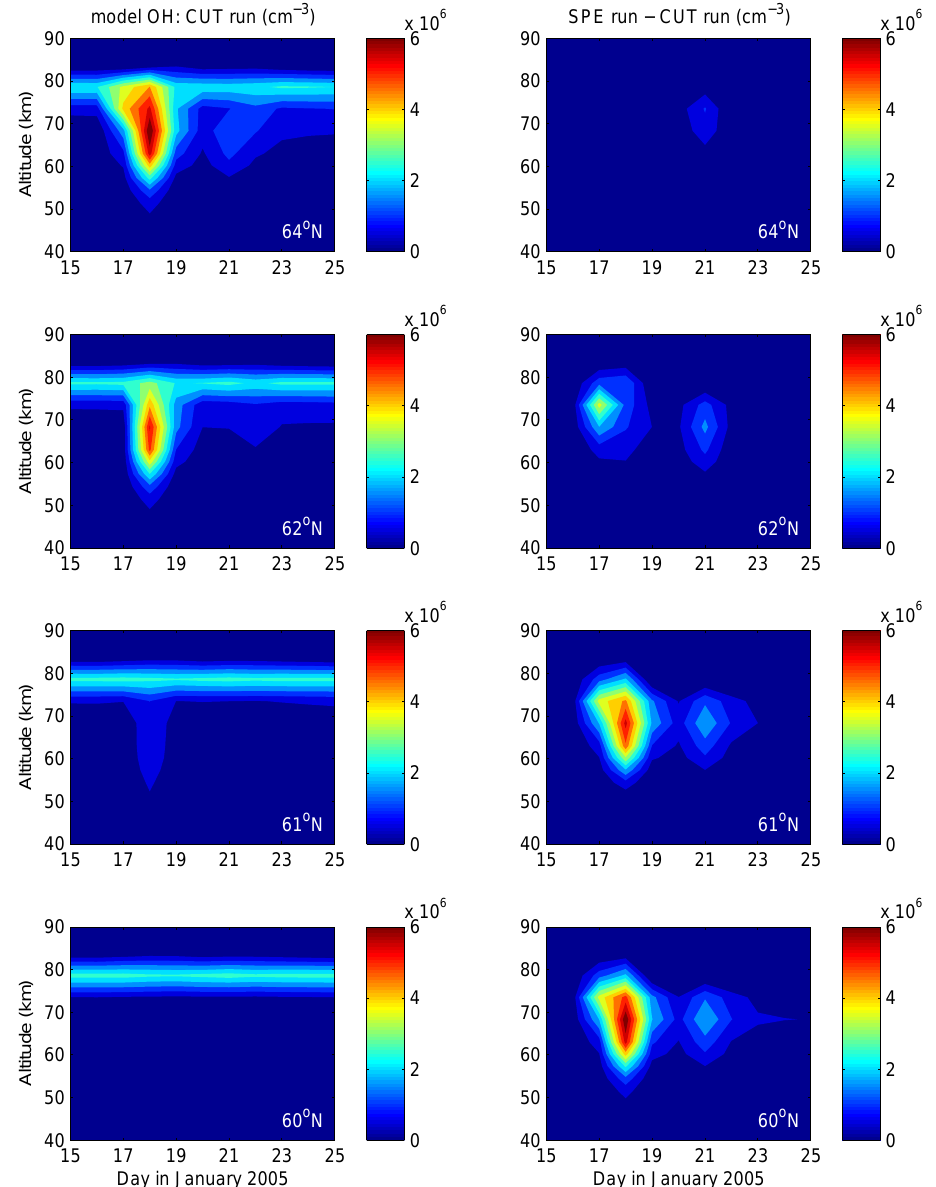
Fig. 5. Left panels: model OH at magnetic latitudes 60, 61, 62, and 64 ◦ N (CUT run results). Concentrations are averages of 03:00– 06:00UT, corresponding to 02:00–05:00 LT (geographic longitude is 15 ◦ W). Right panels: The difference between the SPE (without cutoff) and CUT (with cutoff)